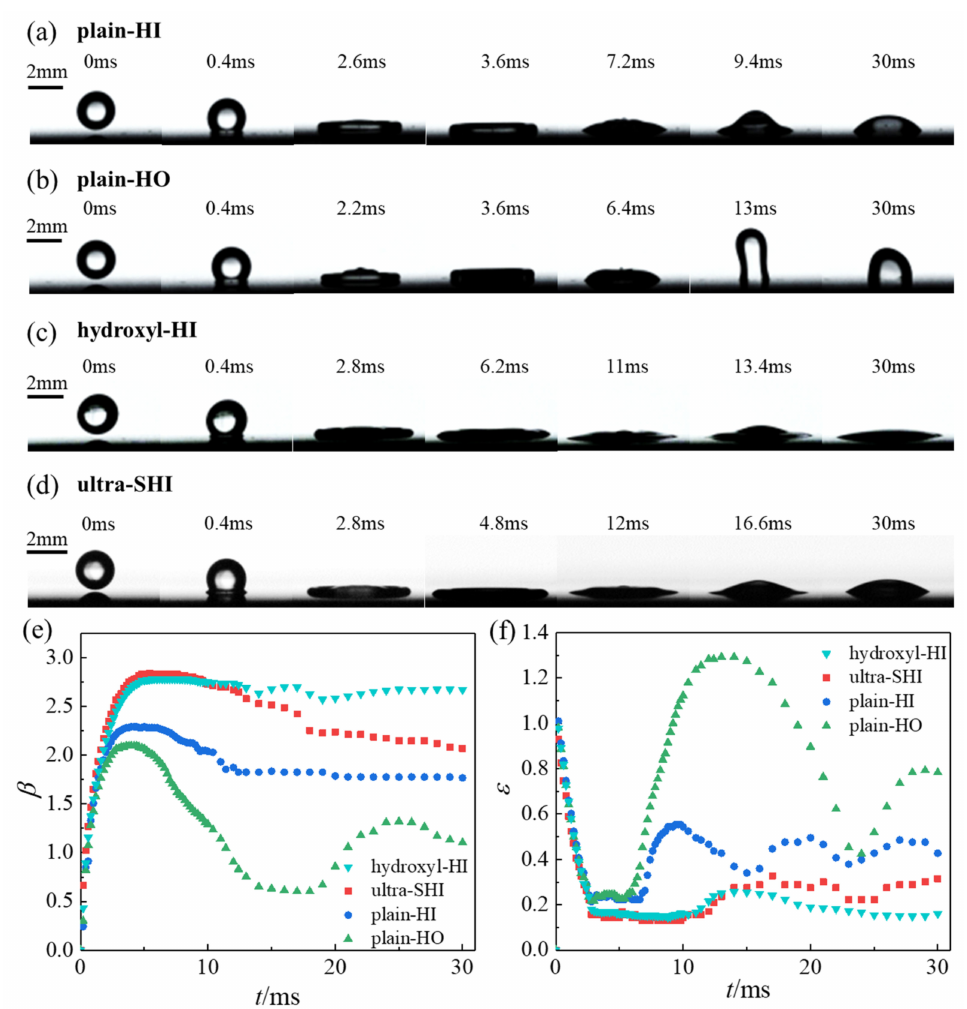
Figure 5. Spreading characteristics of the droplet on the horizontal surface with different static contact angles and contact angle hysteresis values. Spreading dynamics of a droplet impacting upon the ( a ) plain-HI surface, ( b ) plain-HO surface, ( c ) hydroxyl-HI surface, and ( d ) ultra-SHI surface. We = 28.71. Comparison of ( e ) the spreading factor β and ( f ) the dimensionless recoiling height ε of the four test